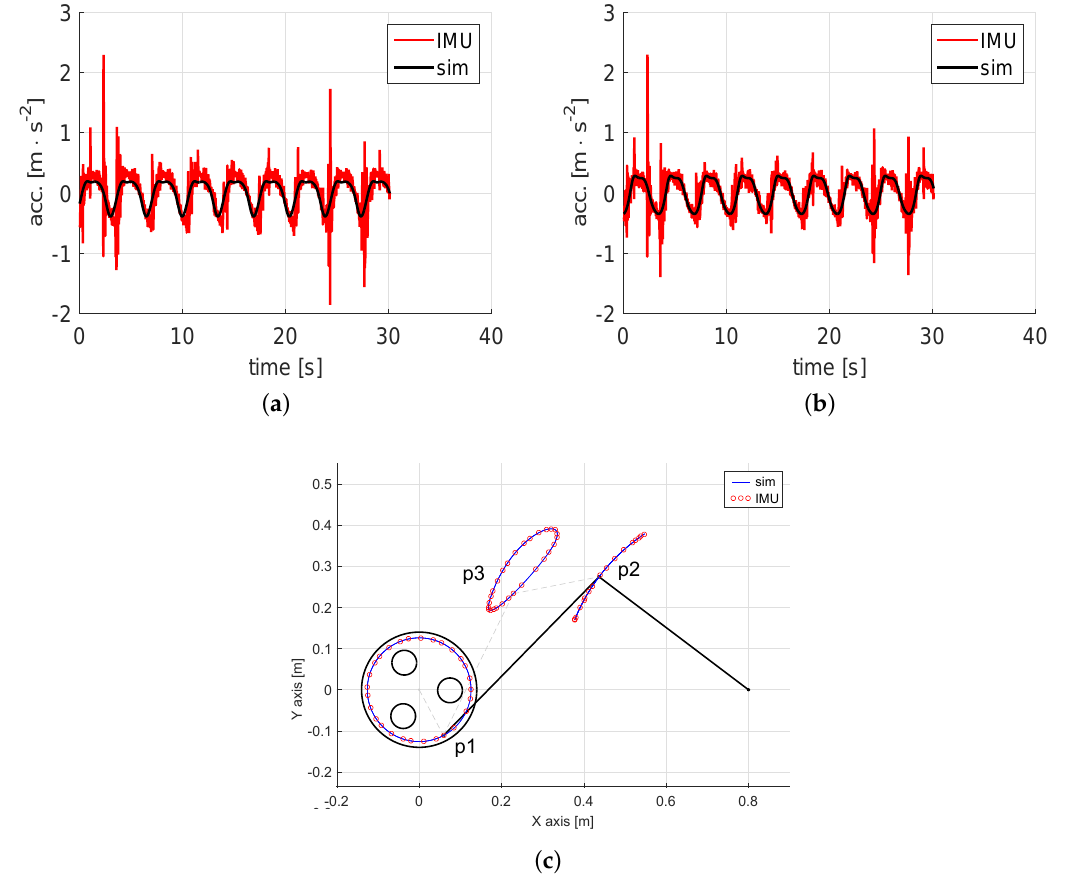
Figure 6. More experimental results: ( a , b ) acceleration measurements and predictions; ( c ) IMU-based and kinematics-based estimations of each interest point trajectory. ( a ) Acceleration of p3 in x axis; ( b ) Acceleration of p3 in y axis; ( c ) Trajectory of interest points p 1 , p 2 and p 3